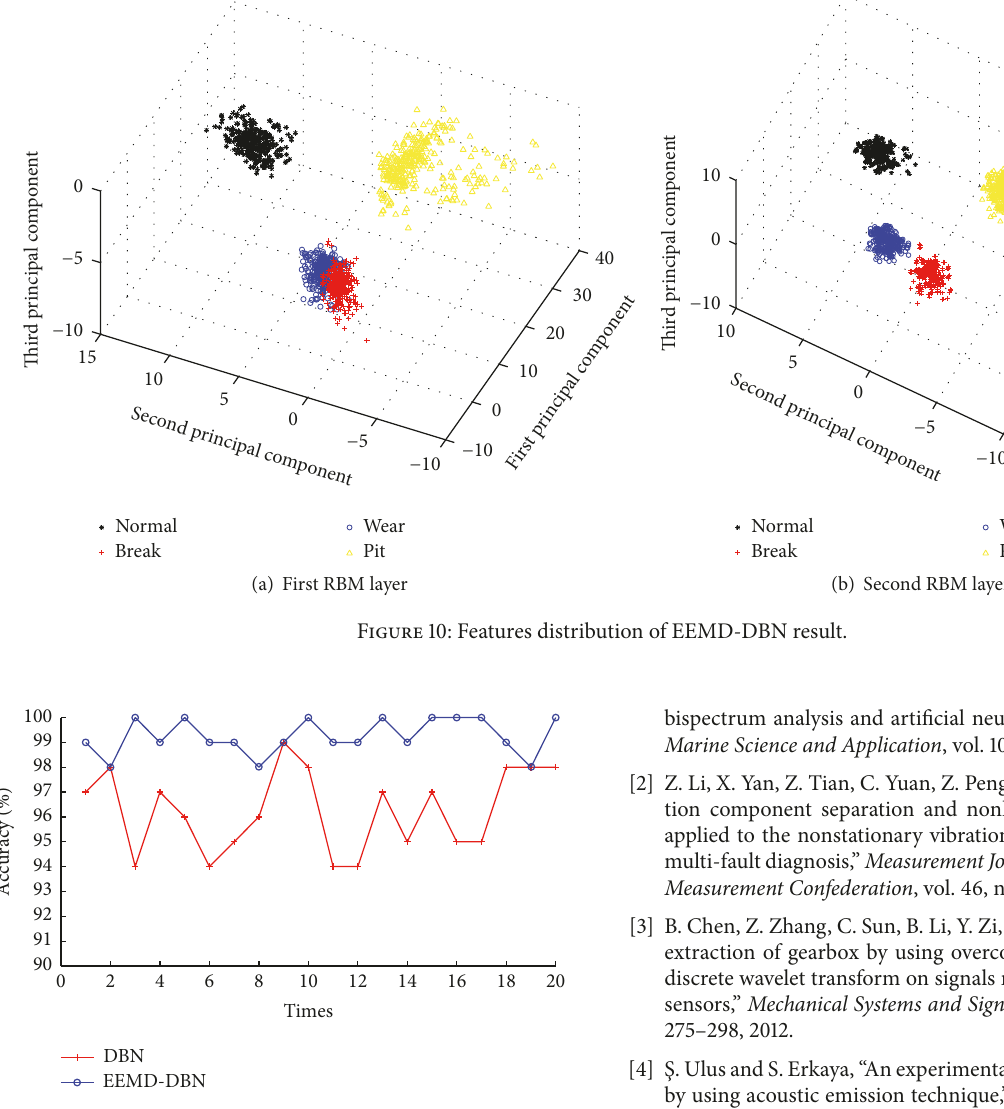
Figure 11: Accuracy of test